Question: Summarize what this figure shows in one sentence.
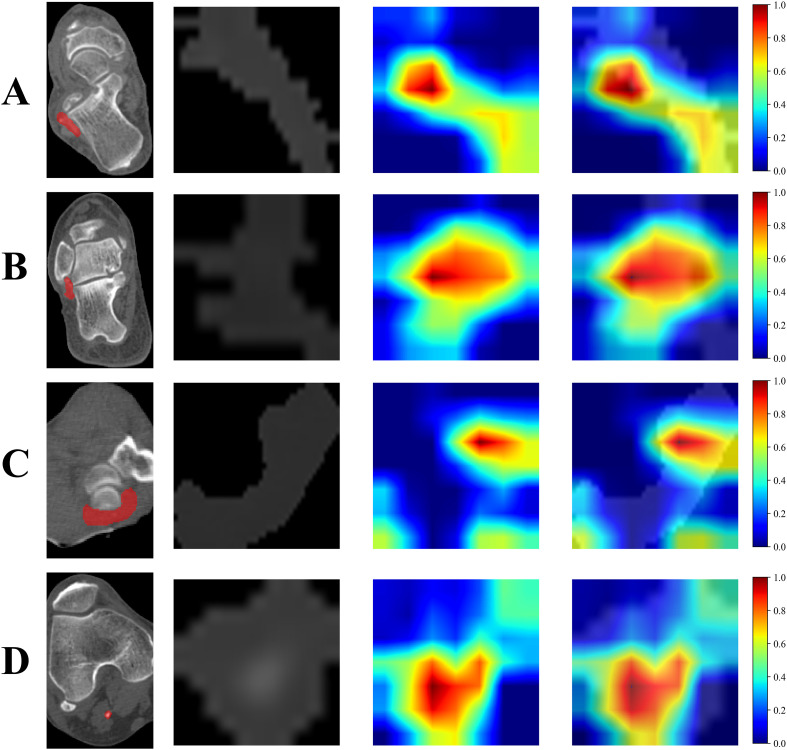
Answer: Grad−CAM heatmaps for representative cases. (A) True−positive. (B) True−negative. (C) False−positive. (D) False−negative.